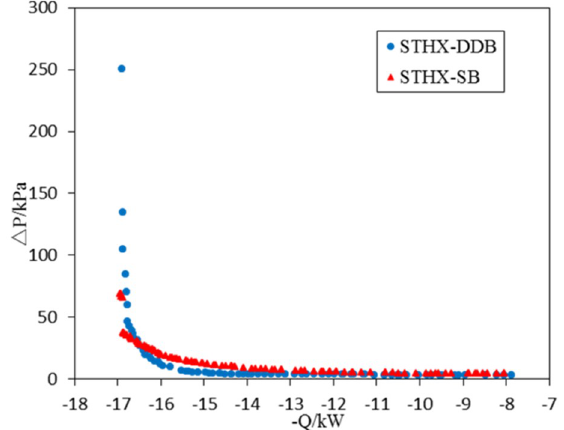
Figure 15. Pareto optimal points.